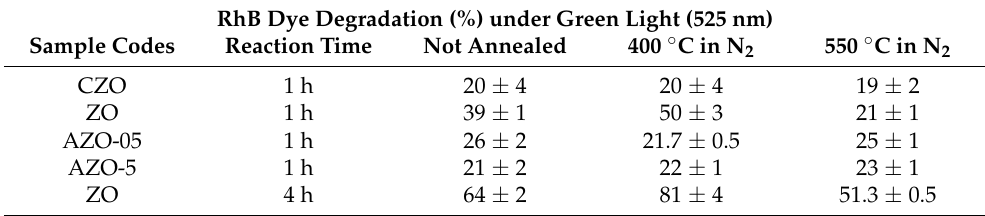
Table 3. Degradation of RhB under green light irradiation for one hour and four hours in the presence of CZO, ZO, AZO-05 and AZO-5 nanomaterials before and after the thermal treatment under nitrogen at 400 and 550 ◦